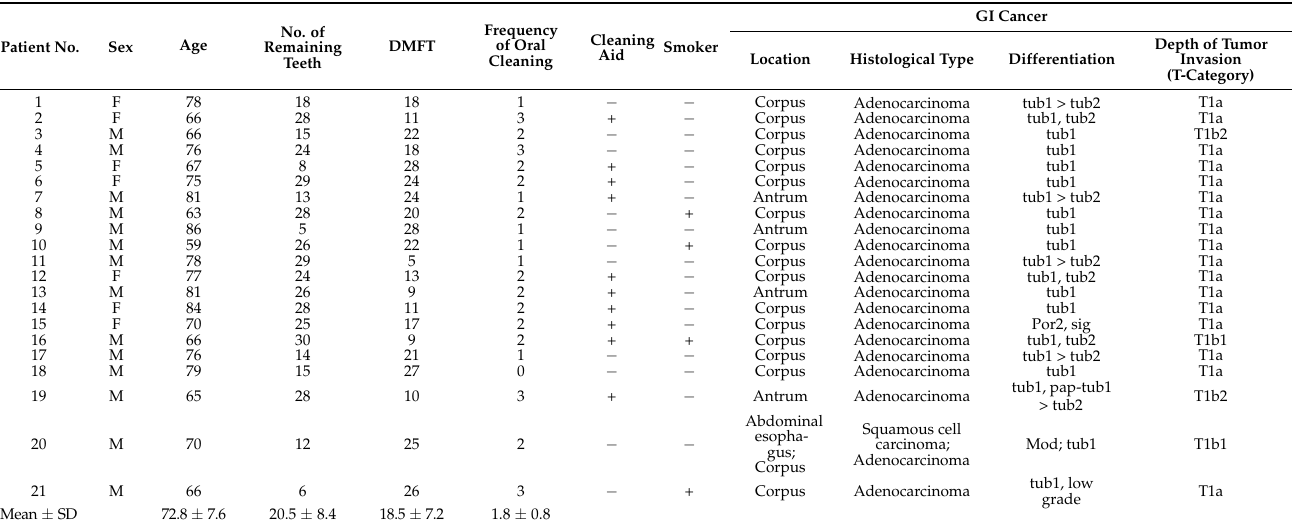
Table 1. Demographic and clinical characteristics of the